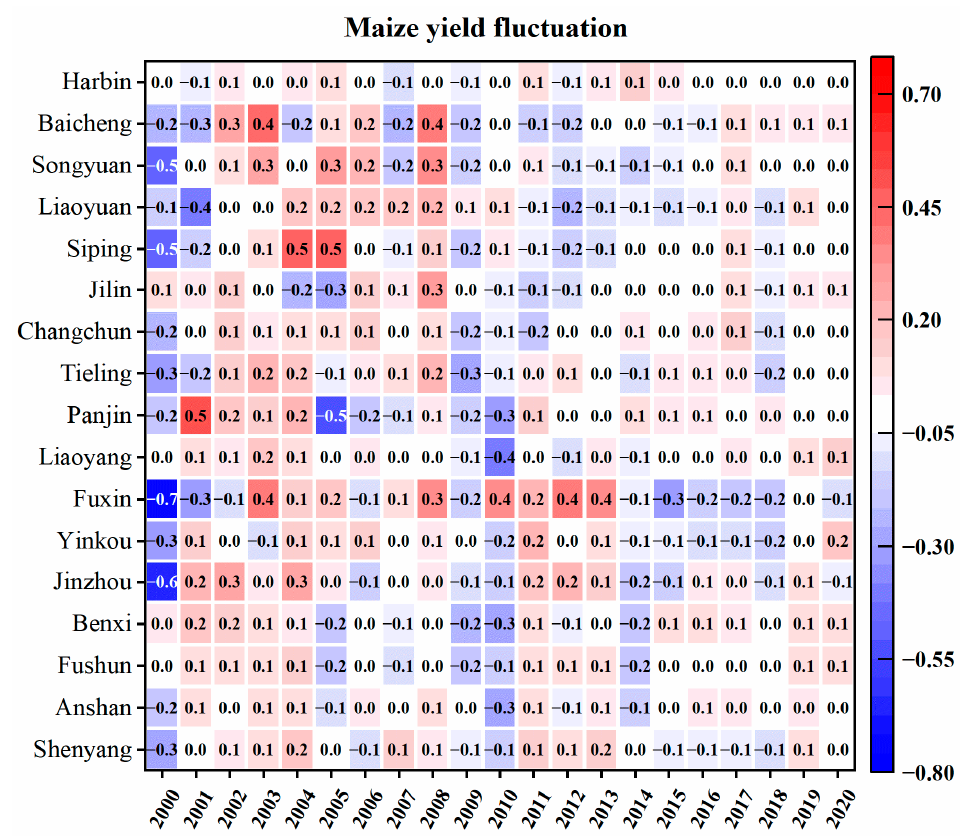
Figure 13. Correlation coefficients between the hazards and yield fluctuations: ( a ) the correlation between drought hazard and yield fluctuations; and ( b ) the correlation between waterlogging hazard and yield fluctuations.